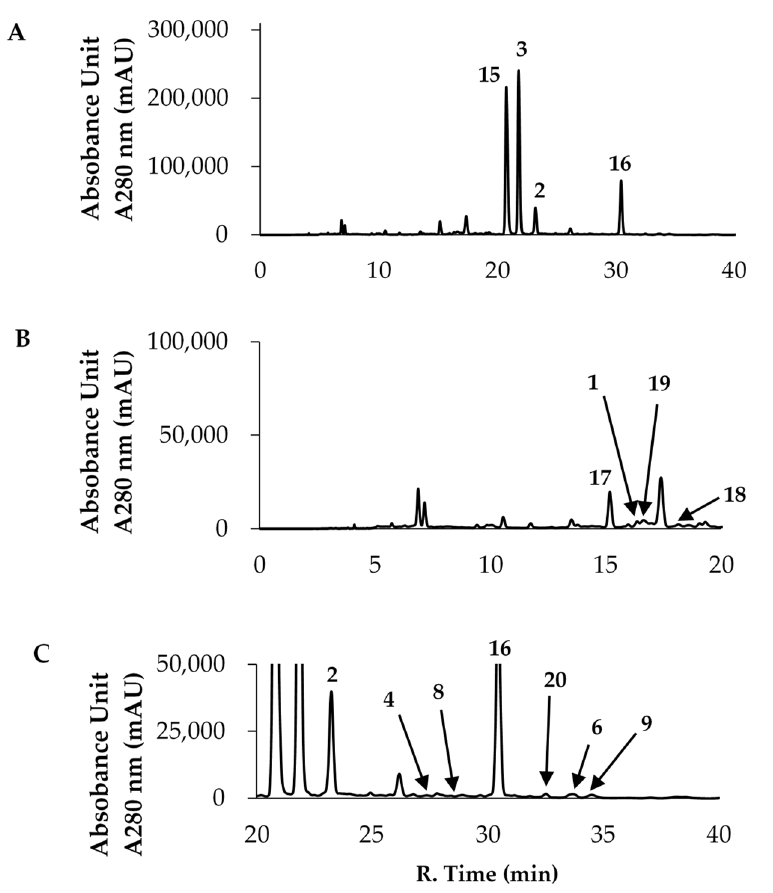
Figure 3. HPLC chromatograms of the methanol extract of green tea leaves. ( A ) Whole chromatogram; ( B ) Magnified chromatogram, 0–20 min; ( C ) Magnified chromatogram, 20–40 min.